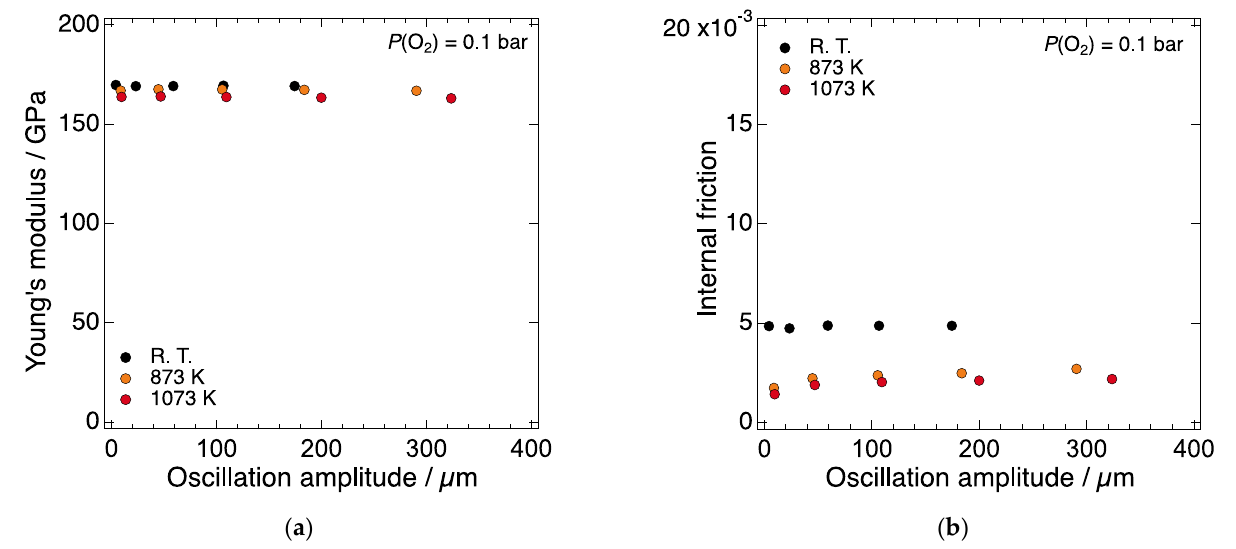
Figure 2. Oscillation amplitude dependence of ( a ) the Young’s modulus and ( b ) internal friction of LN214 at room temperature, 873, and 1073 K under a constant P (O 2 ) of 10 − 1 bar.